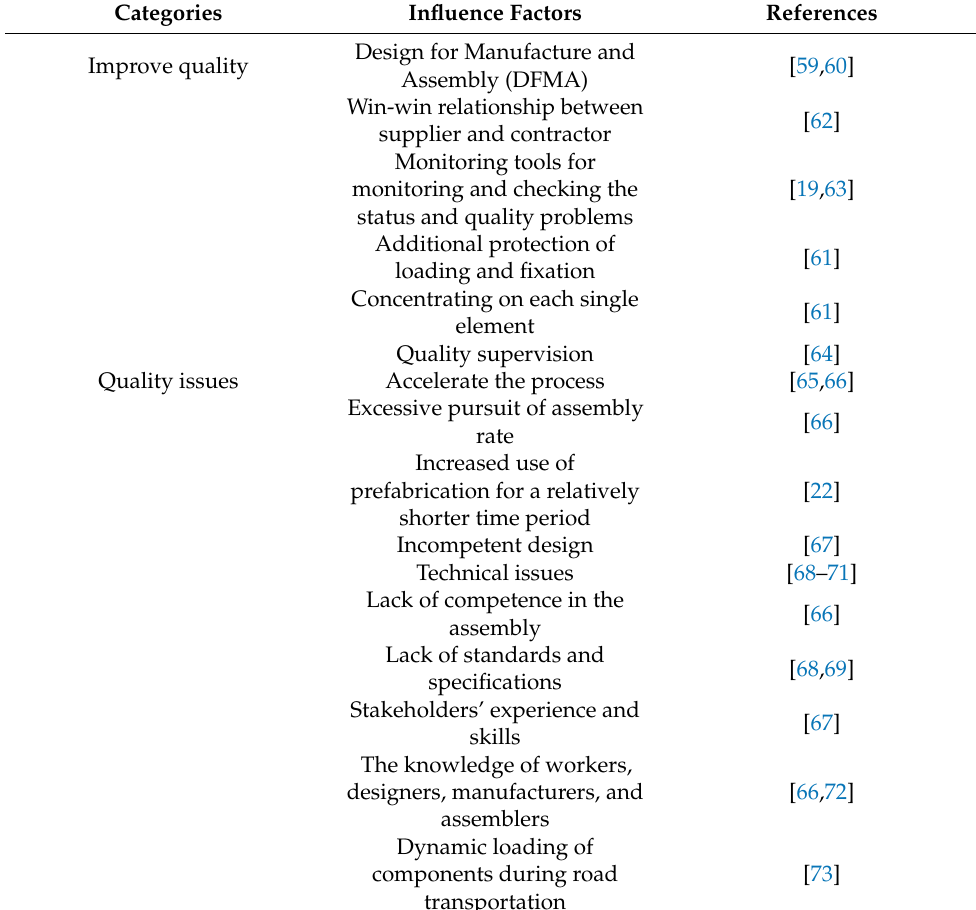
Table 1. Existing study on the key factors influencing the quality of